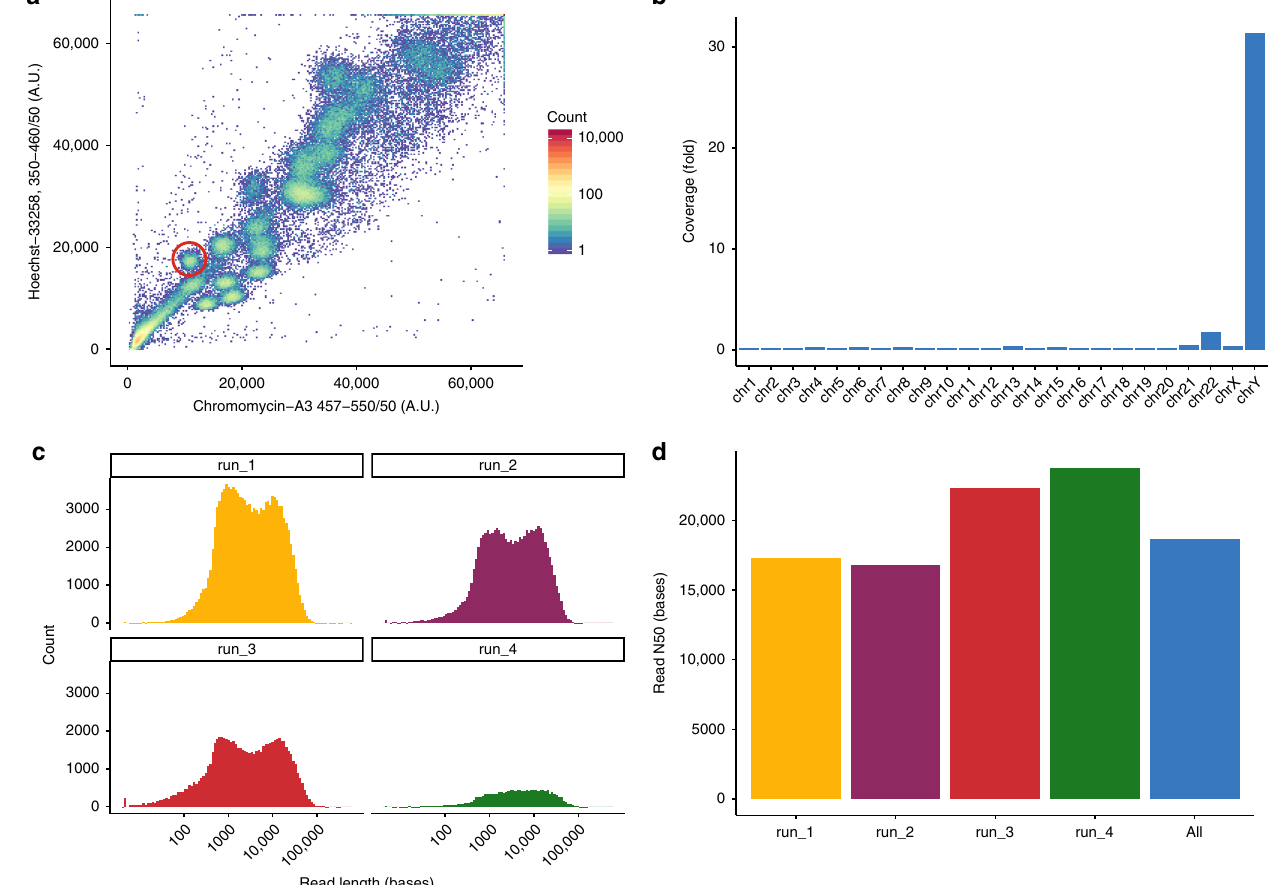
Fig. 1 Flow-sorting and sequencing speci fi city. a Flow-karyogram of a human genome. The different clusters correspond to different chromosomes. The red circle delimits the cluster corresponding to the Y chromosome used for this project. b Enrichment speci fi city of the sequencing data. Sequences on the Y chromosome are ~ 110-fold enriched compared with WGS sequencing. Chromosome 22 partially co-sorts with Y. All other chromosomes are depleted. c Read length (log10 scale) distribution of the four runs. d N50 values for all four runs and the combined dataset. Colors in panels c and d correspond to the different runs. Source data are provided as a Source Data fi